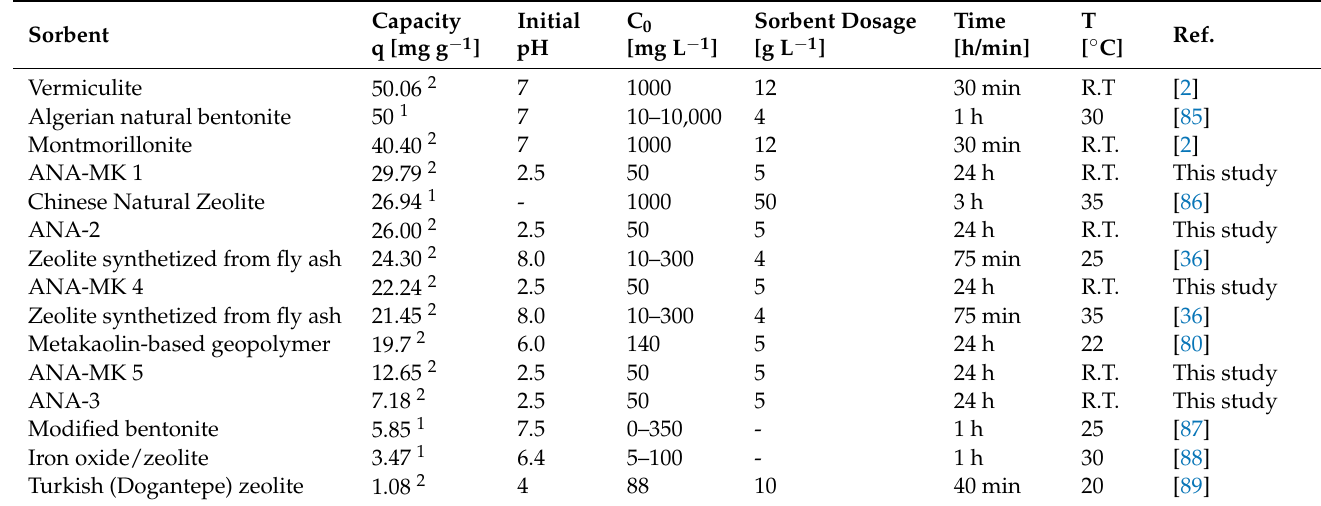
Table 8. Comparison of the sorption capacity q m (mg g − 1 ) of various sorbents for the removal of NH 4+ ions from an aqueous